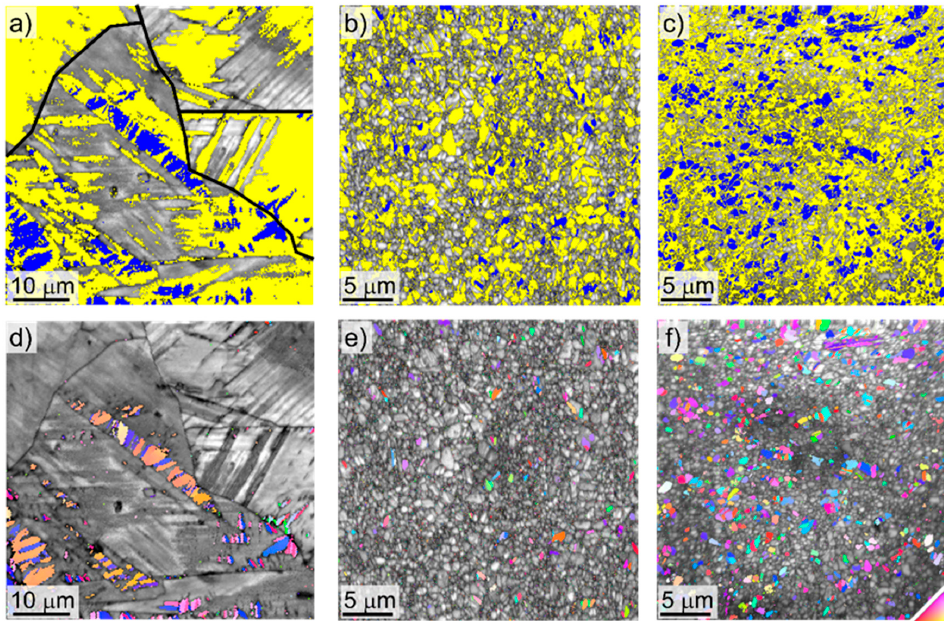
Figure 6. Results of EBSD measurements on CG ( a , d ) and UFG ( b , c , e , f ) material conditions at different total strain amplitudes of ∆ ε t /2 = 0.3% ( a , d ), ∆ ε t /2 = 0.4% ( b , e ) and ∆ ε t /2 = 0.5% ( c , f ). Color code of phase maps ( a – c ): gray—austenite, yellow— ε -martensite, blue— α ’-martensite. Crystallographic orientation maps of α ’-martensite ( d – f ) are shown by inverse pole figure color code of the normal direction.